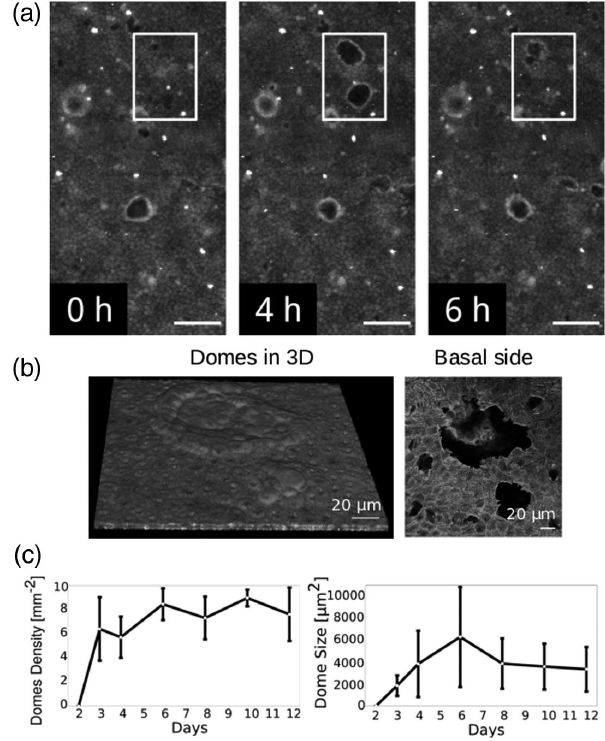
FIG. 19. Domes formation within the epithelial tissue. (a) Cre- ation and dissolution of domelike structures in the bulk of mature MDCK-II monolayers. At 0 h, all cells are in contact with the surface. At 4 h, the domes are formed in the middle of the field of view. The cells are moved upwards and away from the focal plane. Only the base of the domes is visible, in the form of two bright circular structures. At 6 h, the circular structures disappear as the domes collapse and the cells return to the focal plane. All scale bars account for 100 μ m. (b) 3D structure of the domes and corresponding magnified picture of the basal side of the mono- layer. (c) Long-term characterization of the domes ’ average density within the monolayer and